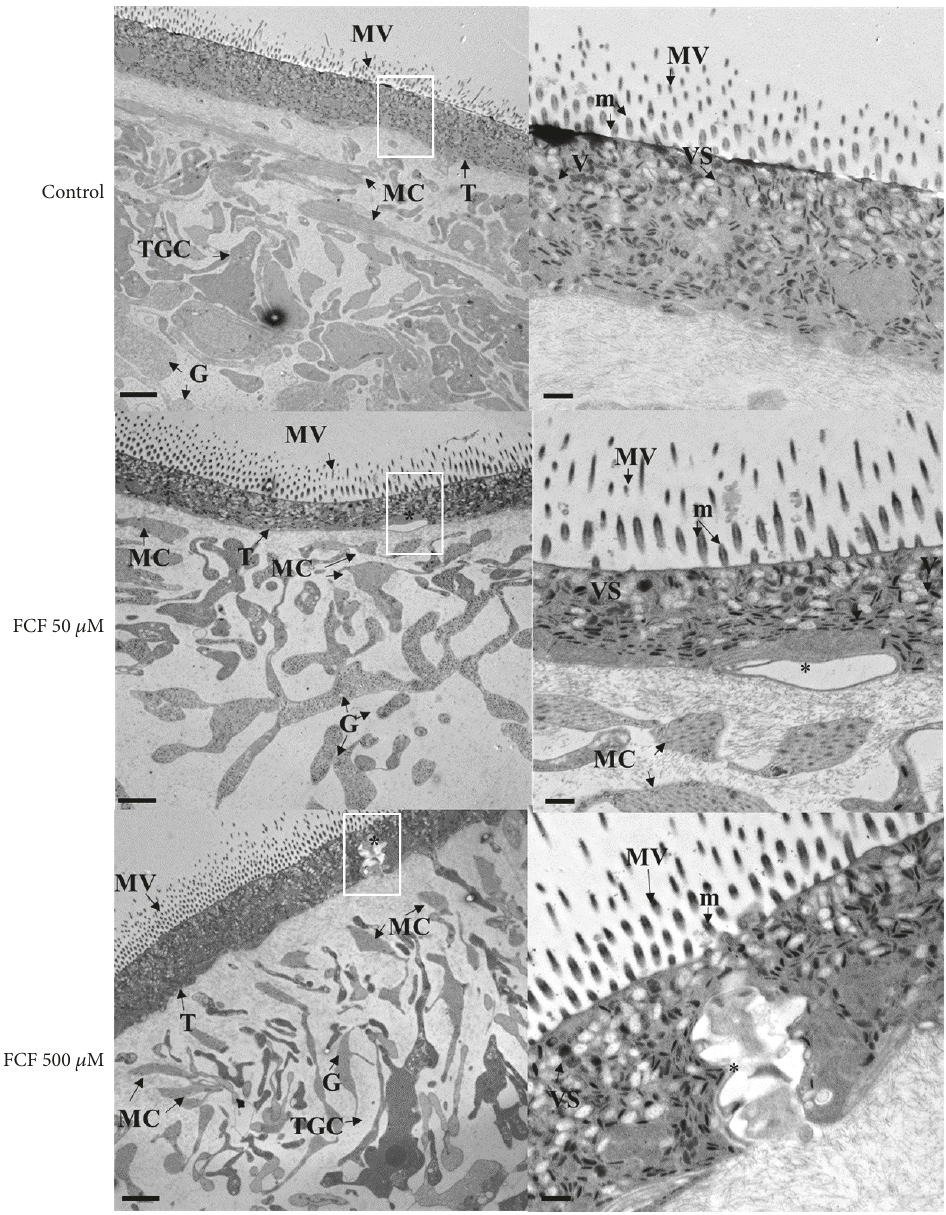
Figure 3: Morphological changes caused by FCF on T. crassiceps tegument visualized by transmission electron microscopy. MC, muscular cell; TGC, subtegumentary cell; G, glycogen; m, microtrics; MV, microvilli; V, vacuoles; VS, vesicles; T, tegument. Regions presenting changes or damage are indicated by an asterisk. Scale bar, 500 nm. The insert marked within a white box is shown at higher magnification to the left; it shows the outermost region of the tegument (scale bar, 2 nm). All cysticerci were exposed for 1 h to either 0.1% DMSO (control) or varying concentrations of FCF. The ultrastructure of the tegument in the control reveals the classic arrangement of cells and intact microvilli. In FCF-treated cysticerci, microvilli, vesicles, and microtrics are more